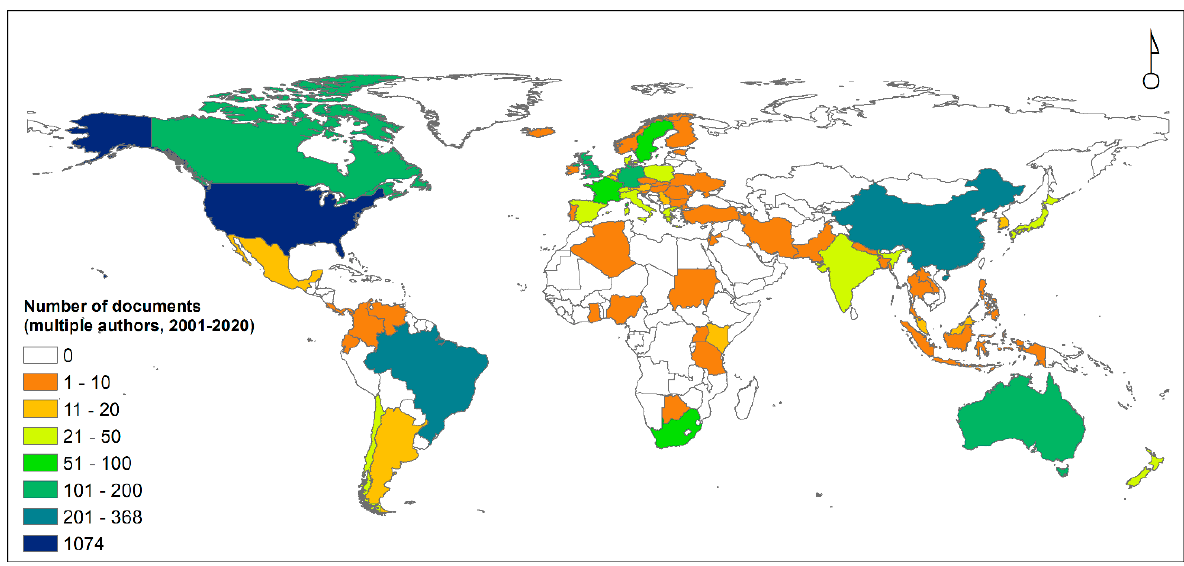
Figure 3. Country co-authored counting of English published documents on riparian zones (2001–2020).